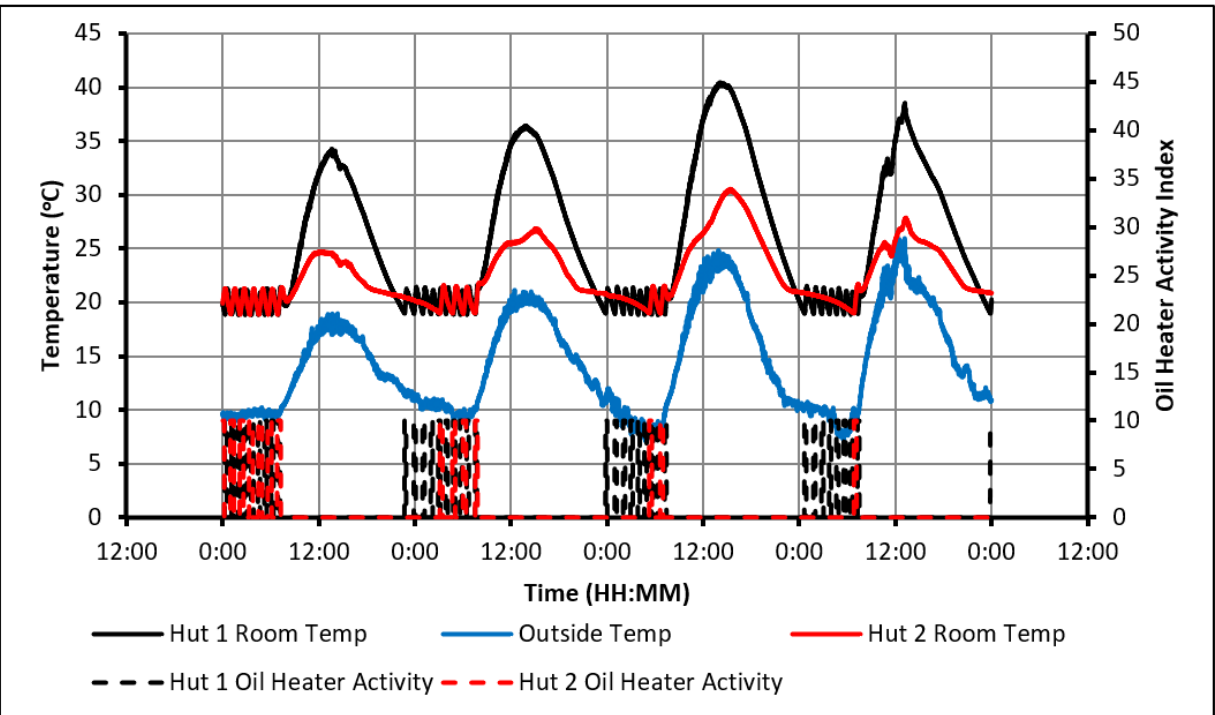
Figure 10. Temperature profiles and heater activity (19 – 21 °C temperature constraints).